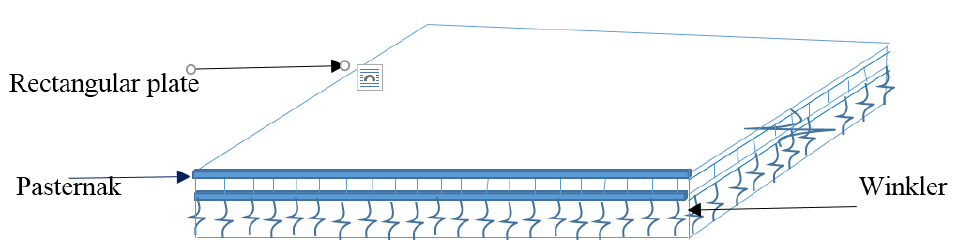
Figure 1. Rectangular plate resting on two-parameter foundations